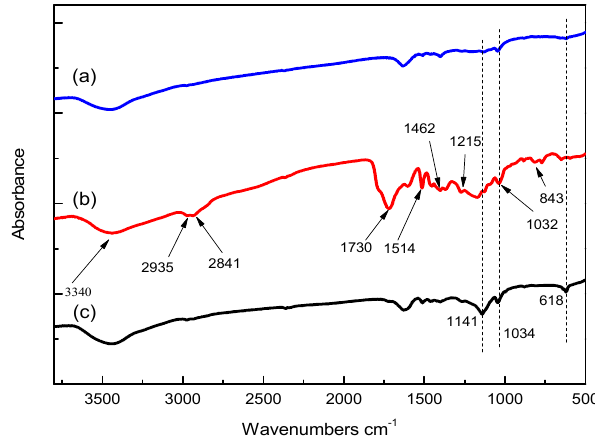
Figure 5. FT-IR of ( a ) SL, ( b ) bio-oil and ( c ) solid residue.